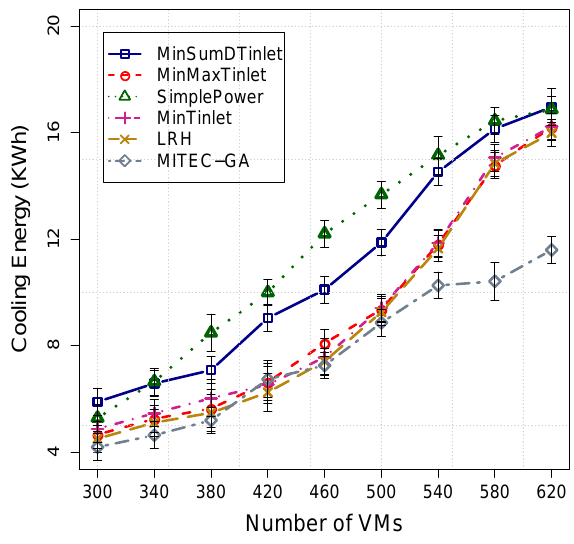
Figure 4. Cooling energy consumption vs. VM numbers.